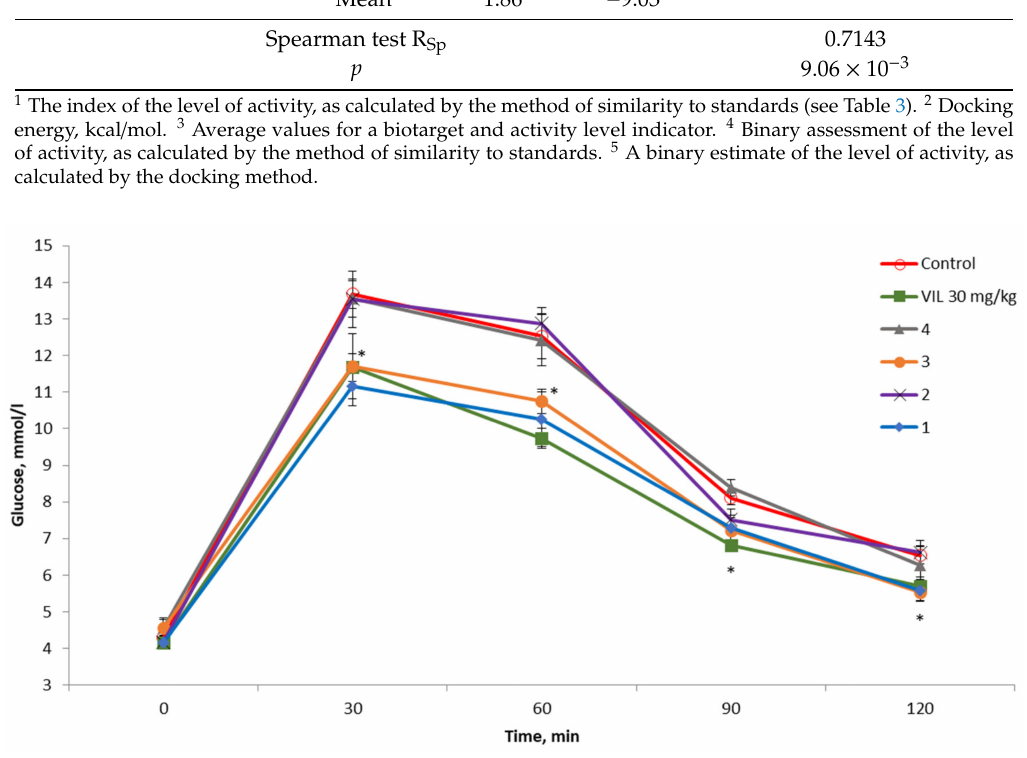
Figure 2. Oral glucose tolerance test (OGTT) results in C57BL / 6 mice. All tested compounds ( 1 – 4 ) were administered at a dose of 30 mg / kg. * p < 0.05 as compared with untreated